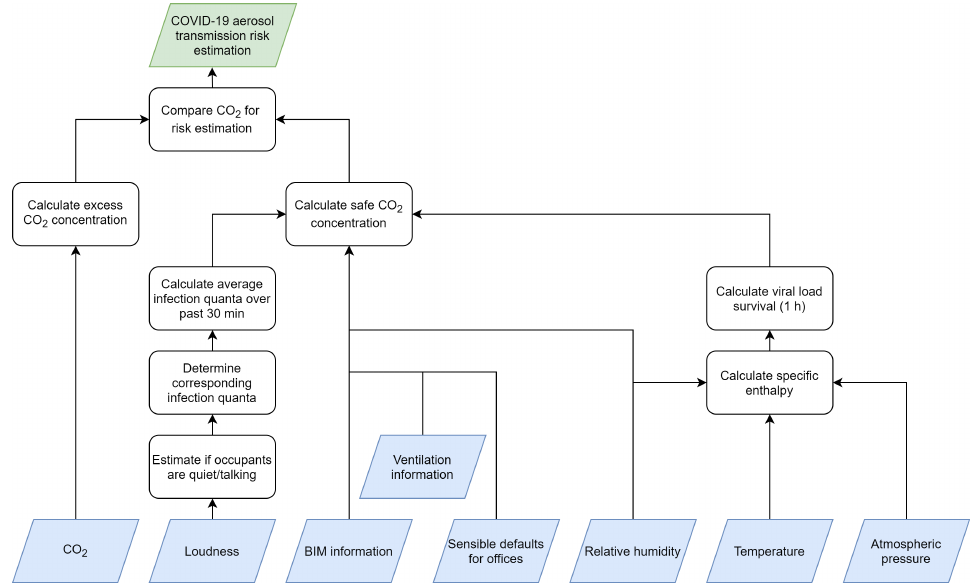
Figure 1. Overview of the coronavirus disease 2019 (COVID-19) aerosol transmission risk estima- tion